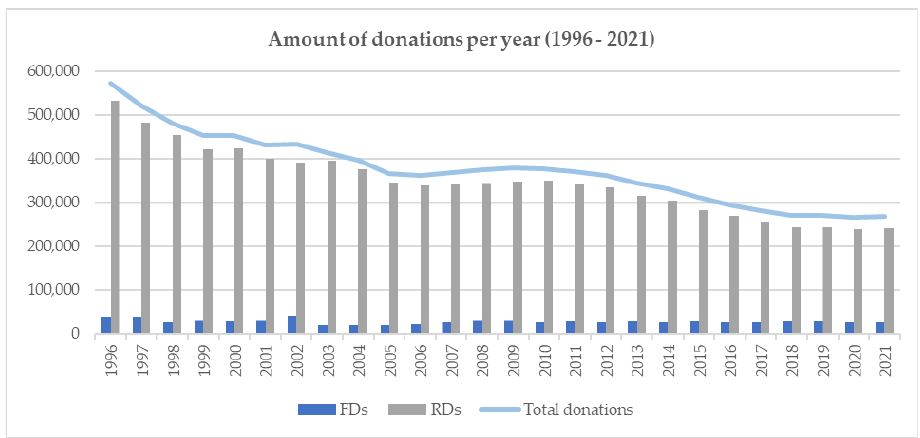
Figure 1. Amount of total donations and donations from RD and FD from 1996-2021.